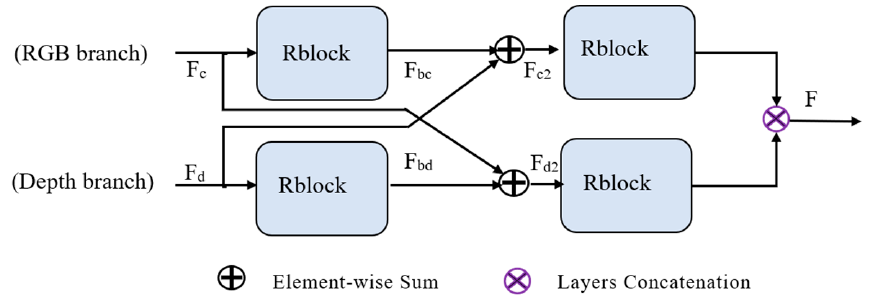
Figure 3. Overview of the cross-fusion module. Rblock denotes the residual block. F c denotes the output of the RGB feature extraction branch and F d is the output of the depth branch. F c2 and F d2 are the middle output of this module and F is the final output.